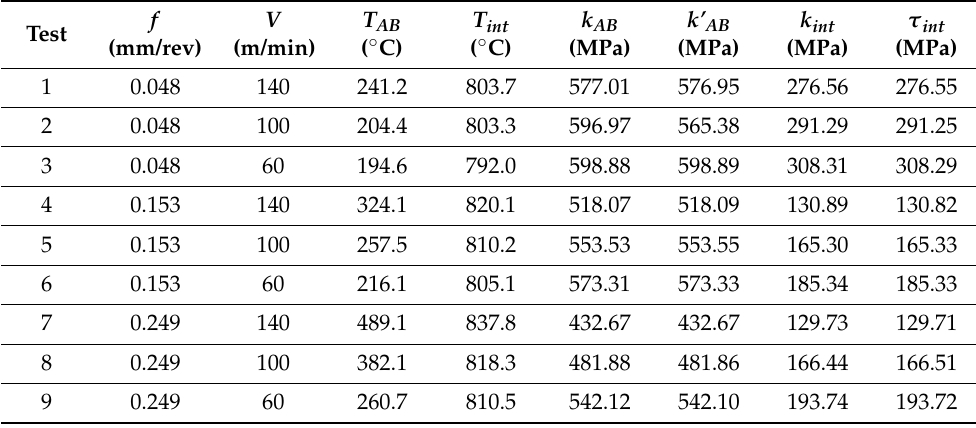
Table 9. The values determined for a p = 0.5 mm, α = 7°.